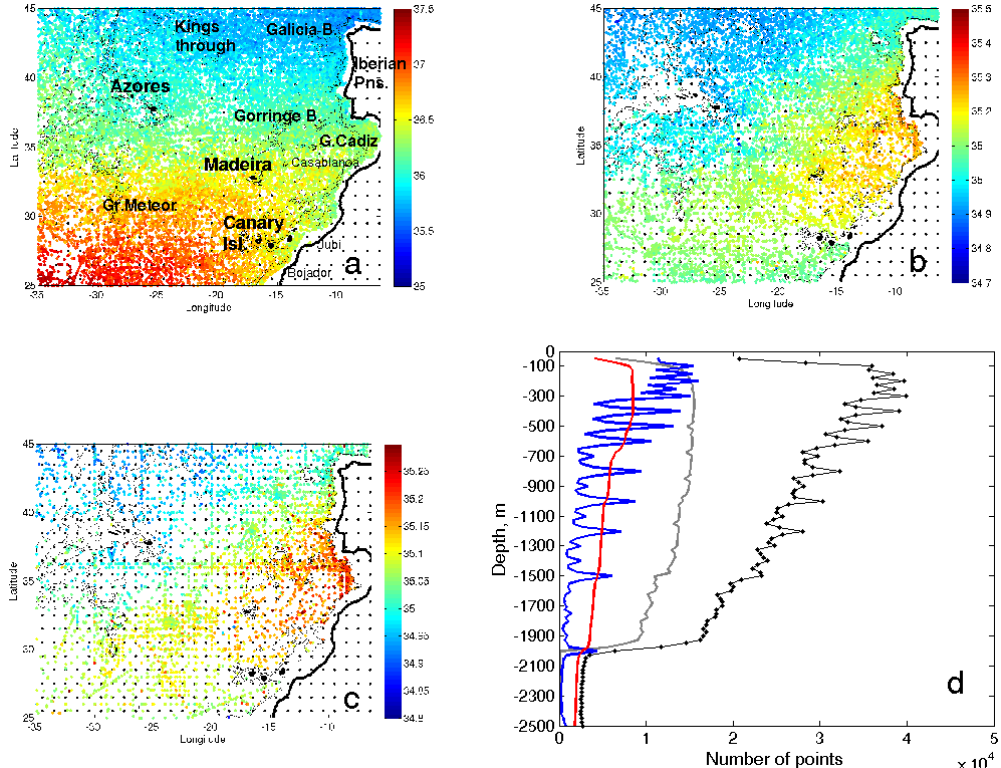
Figure 1. Scatterplot of valid temperature–salinity data points at (a) 100m, (b) 1900m, (c) 2000m, and (d) the vertical profile of the number of valid temperature–salinity data points. The WOA09 grid is shown in panels (a–c) with black dots. In panels (a–c) , the colour scale represents salinity. In panel (d) , the black line with markers is the total number of data points; grey line – PFL data only; red line – CTD data only; blue line – OSD data